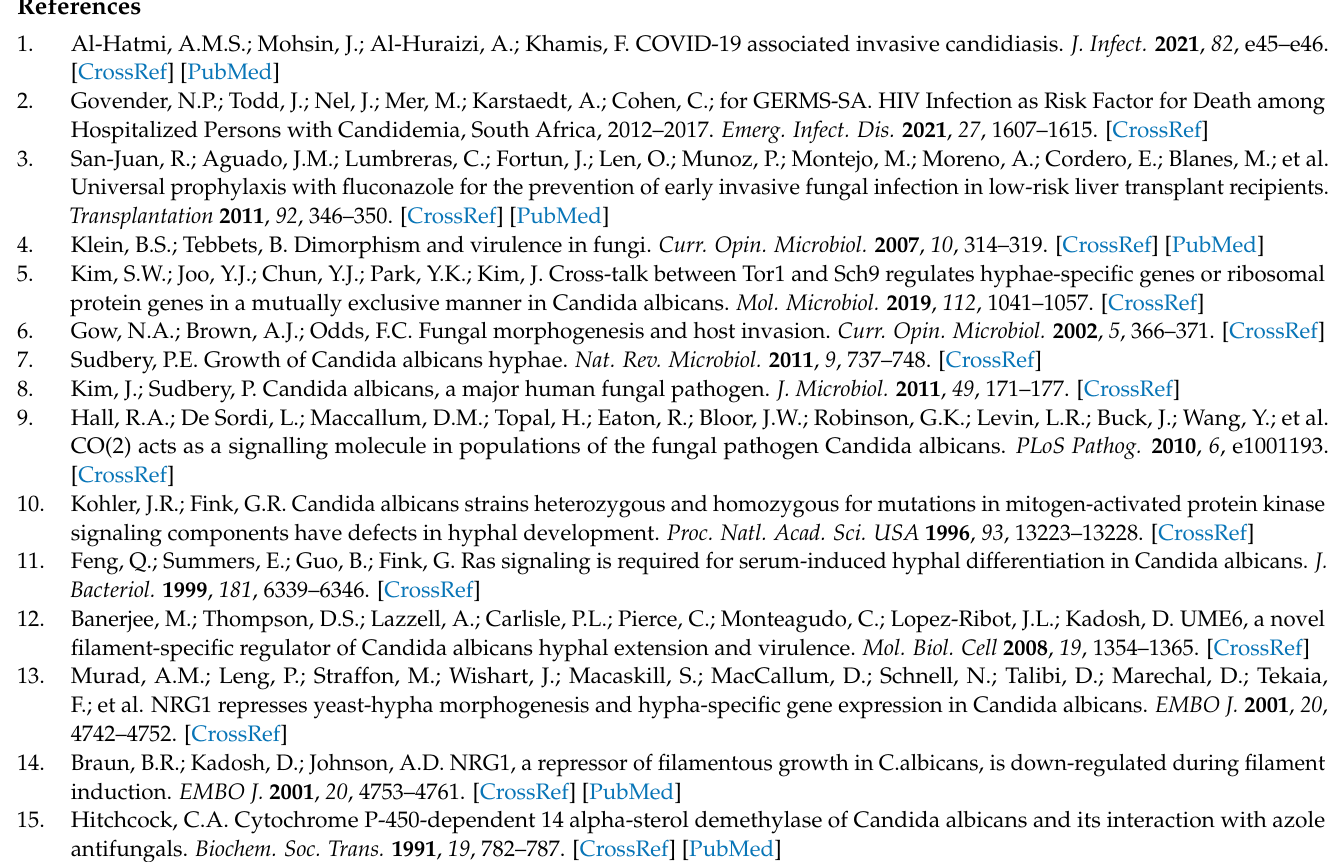
Table S1: Oligonucleotides used in this